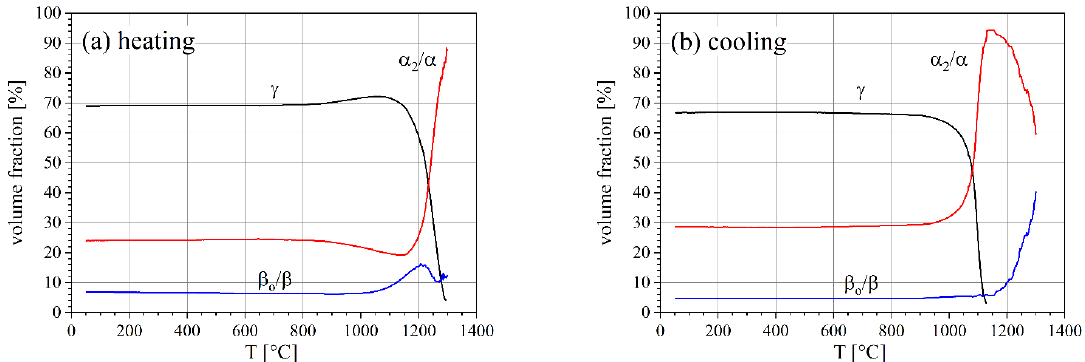
Figure 5. Phase fractions of γ , α 2 / α , and β o / β as a function of temperature ( a ) during heating and ( b ) during cooling, both with 20 K min –1 . The relative error is between 1% and 4% of the volume fractions except for at high temperatures where significant grain growth occurs, leading to larger errors.